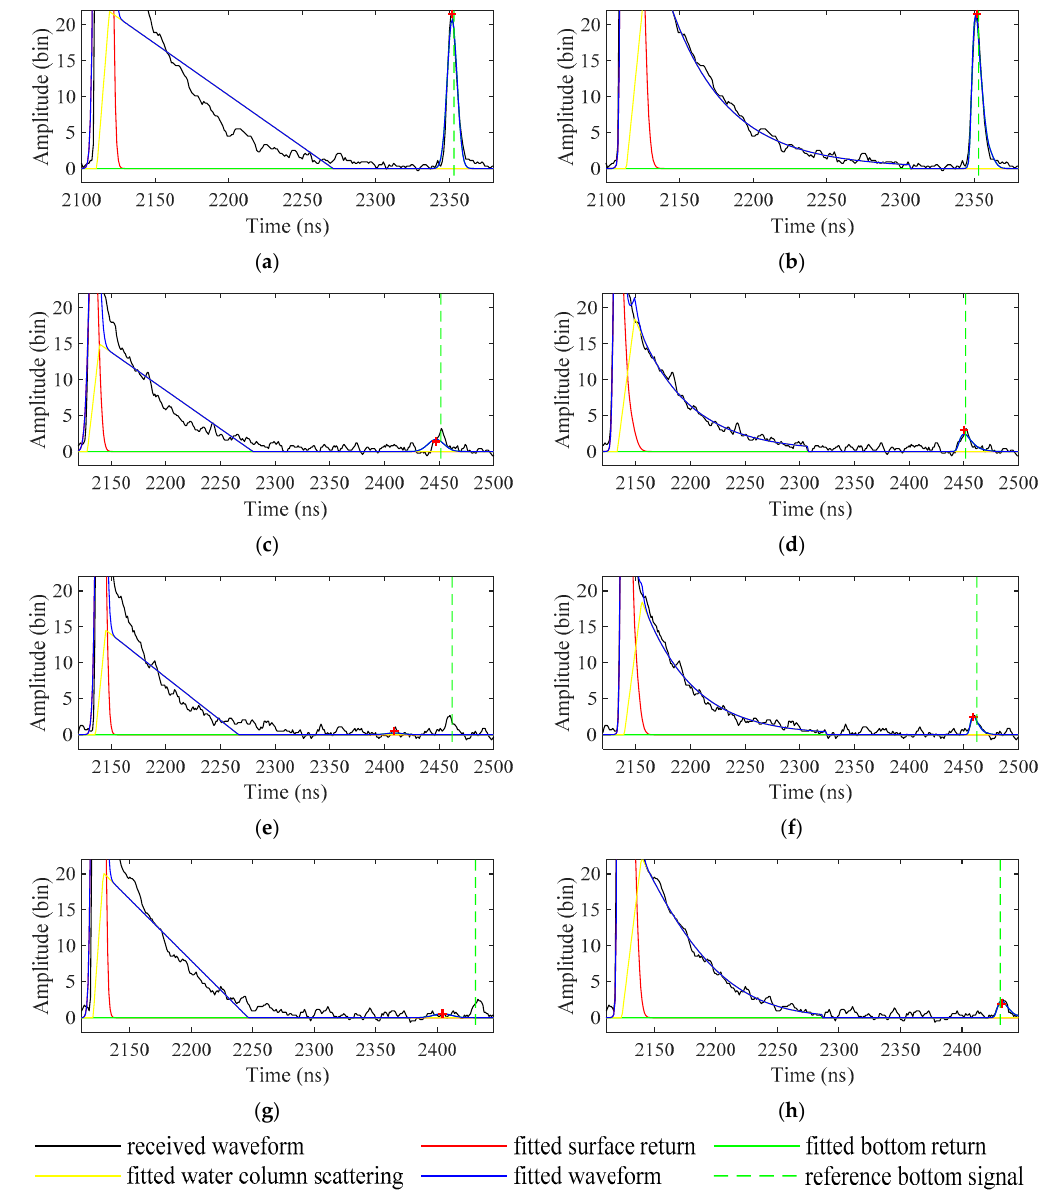
Figure 21. Waveforms fitted with ( a , c , e , g ) the quadrilateral model and ( b , d , f , h ) the EFSP model (zoom in the bottom). The peak of the fitted bottom return is marked by “+”.